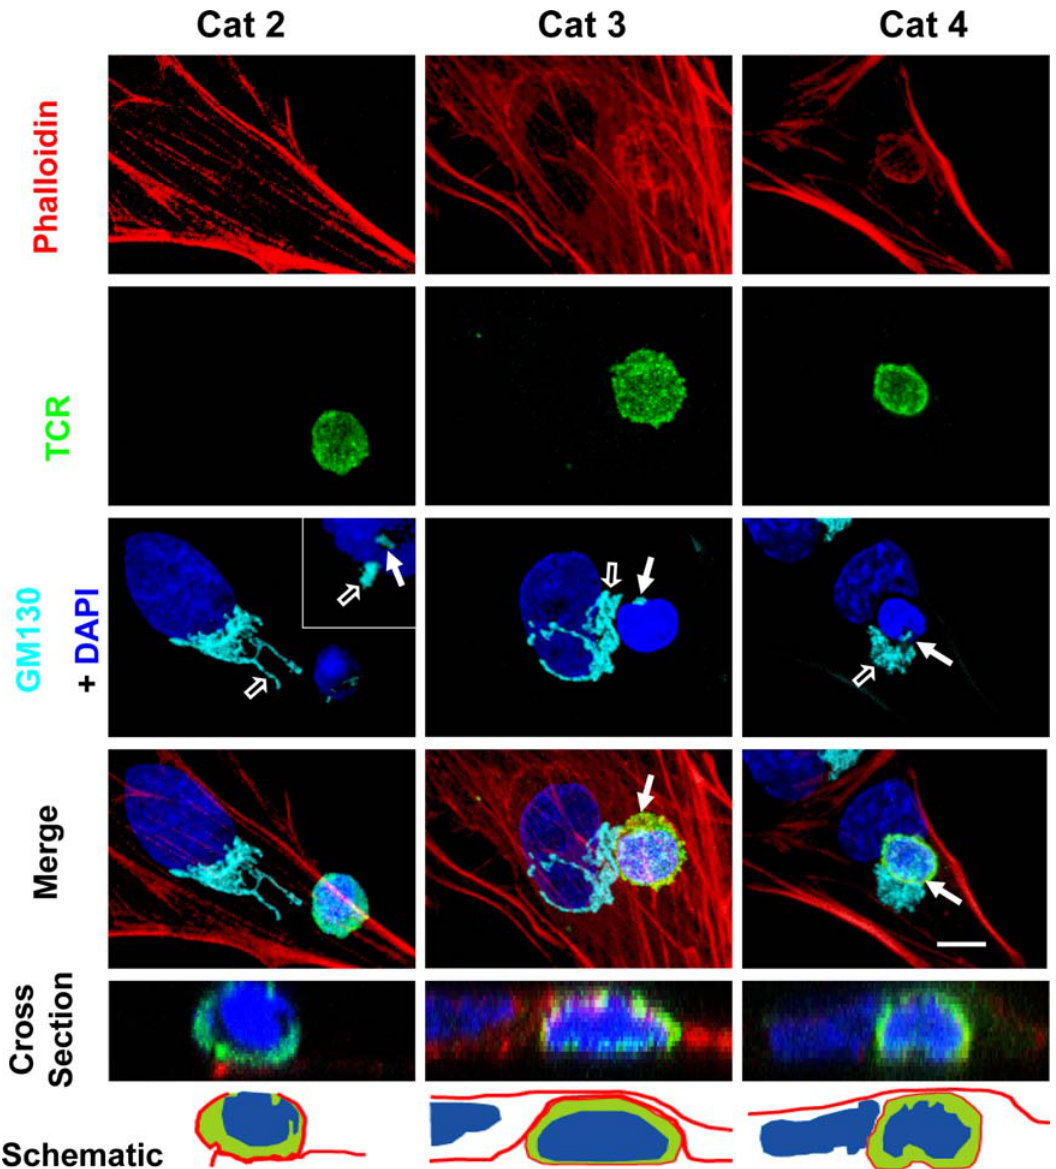
Figure 11. Immunological synapses between allogeneic T cells and Sprague-Dawley astrocytes in vitro : in T cells, the Golgi apparatus and T cell receptor polarize towards the target astrocytes, and in target astrocytes, the Golgi apparatus polarizes toward the immunological synapse. This figure shows confocal images of primary cultured astrocytes from neonatal rat cortex derived from outbred Sprague Dawley rats interacting with allogeneic T cells from adult Lewis rats (last column), or outbred Sprague Dawley rats (columns 1 and 2); note that since Sprague Dawley rats are outbred cells from different individuals are allogeneic to each other. One such interaction is shown for each of categories 2, 3 and 4 (as described in Figure 2A for the in vivo interactions). Actin is labeled with phalloidin (red), and nuclei with DAPI (blue). TCR and GM130 are immunofluorescently labeled and shown in green and cyan, respectively. The Golgi apparatus of T cells is indicated by a full white arrow; the Golgi apparatus of the target astrocytes is indicated by a white arrow outline. The bottom three panels are vertical cross sections through the T cells, revealing that in the Category 2 interaction, the T cell is superficially apposed to the target, while in the Category 3 and 4 interactions, the T cell is deeply embedded in the target. In the Category 2 interaction, the Golgi body appears to be streaming into the process contacted by the T cell. In the Category 3 interaction, the Golgi is focused in the space between the two nuclei, and in the Category 4 interaction, the T cell is interposed between the nucleus and the Golgi apparatus of the target cell. In the third and fourth panel of each column the Golgi apparatus of the T cell is indicated with a white arrow (this indicates the location of the presumed immunological synapse; for the interaction illustrated for Category 2, the inset illustrates an optical section through the lower part of the T cell actually contacting the astrocyte–due to this anatomical arrangement, the Golgi apparatus appears to be surrounded by the T cell nucleus-). All categories of interaction were detected in the Lewis-Sprague Dawley or Sprague Dawley-Sprague Dawley combinations. In the majority of interactions in which the target Golgi displays the morphology depicted here, the T cell Golgi and the greatest accumulation of TCR immunofluorescence (i.e., the immunological synapse) are co-localized and in contact with the target cell; the TCR polarization can be seen clearest in the fifth panel (cross-section) of the left hand column, and the large accumulation of TCR immunoreactivity towards the intercellular contact seen in the fourth panel (merge) of the middle column. The sixth (bottom) panel of each column is a schematic rendition of the cross section shown in the fifth panel, to illustrate the close spatial relationship between the T cells and allogeneic astrocytes. Scale bar=6 m m.